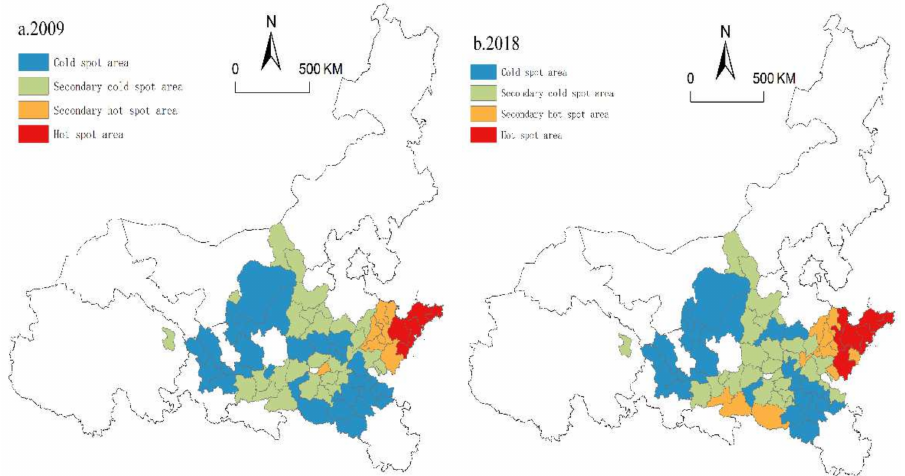
Figure 6. Spatial pattern of urban HQD in 2009 and